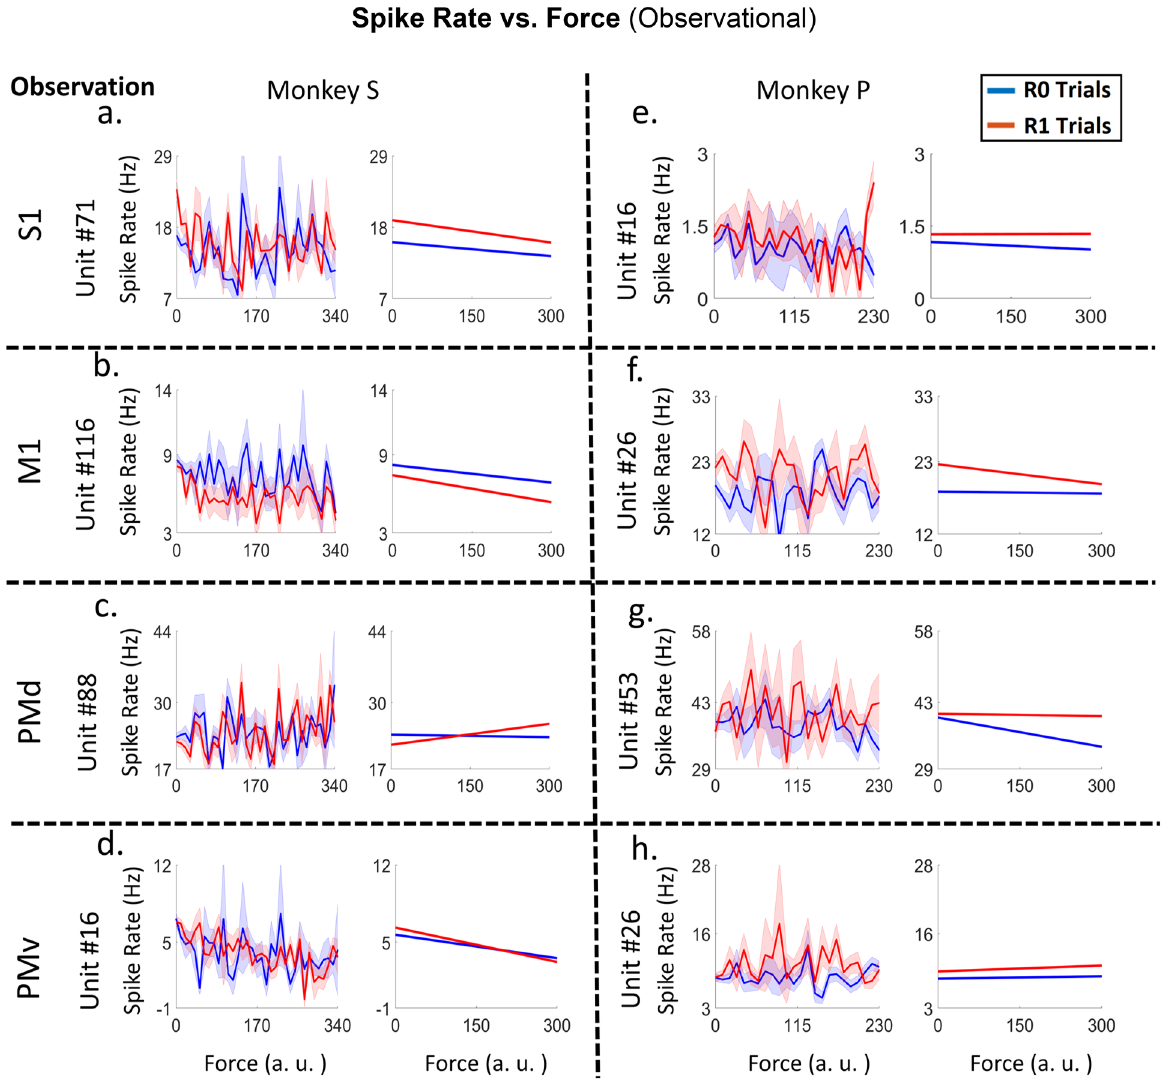
Figure 9. Plots of spike rate vs. force (left subplots) and their linear tuning curves (right subplots), for example, units from cS1 (plot a, e ), rM1 (plot b, f ), PMd (plot c, g ) and PMv (plot d, h ) cortices of both NHPs (for NHP S plots a, b, c, and d and for NHP P plots e, f, g, and h ). The units presented had significant differences between R0 and R1 groups (ANCOVA, F-test, p < 0.05) force tuning curves during observational blocks. Red lines indicate rewarding trials (R1), and blue indicates non-rewarding trials (R0). See Fig. 10 for population results and Fig. S15 for the manual version of this